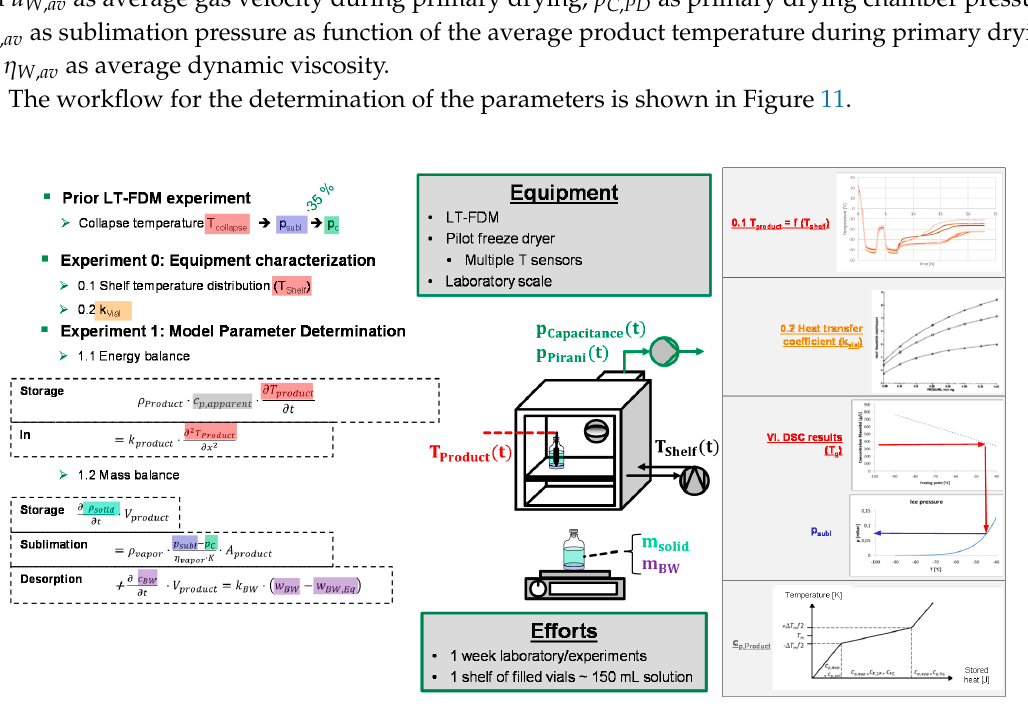
Figure 11. Workflow summary for parameter determination.